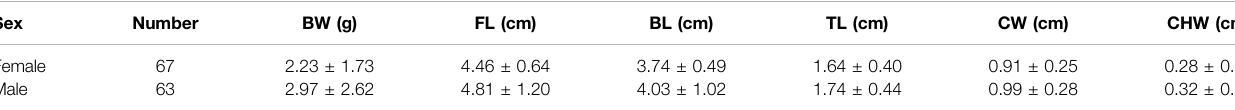
TABLE 2 | Comparison of male and female growth traits.